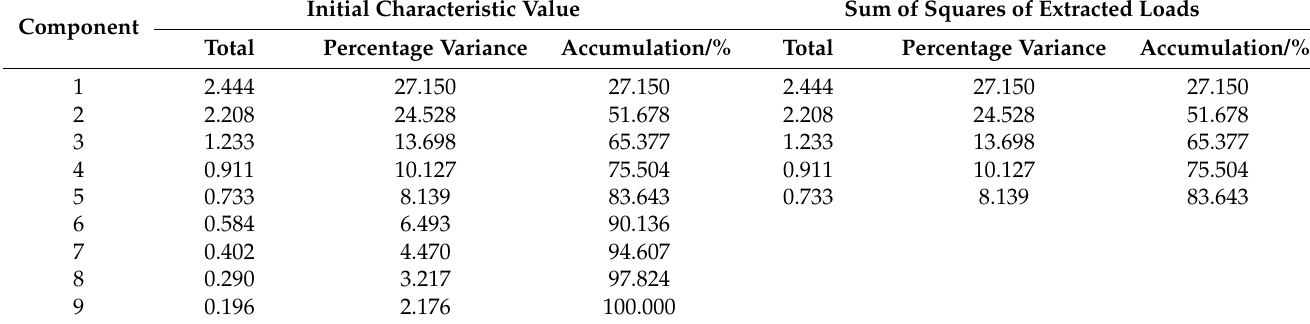
Figure 6. Gravel diagram of PCA.